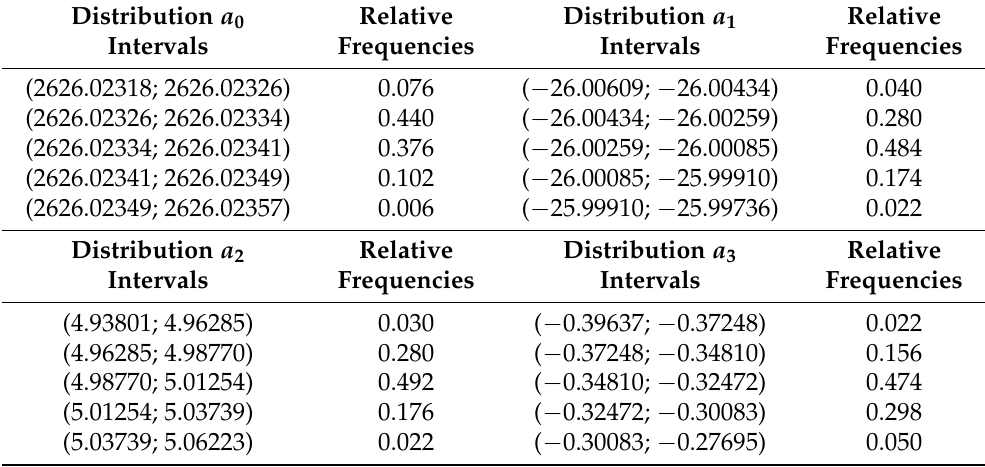
Table 1. a 0 = 2626, a 1 = − 26, a 2 = 5, a 3 = −